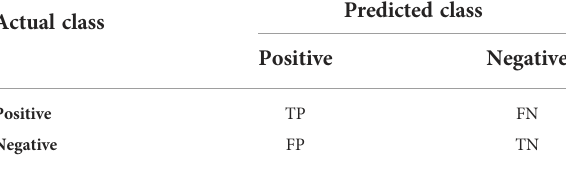
TABLE 3 The confusion matrix for the possible